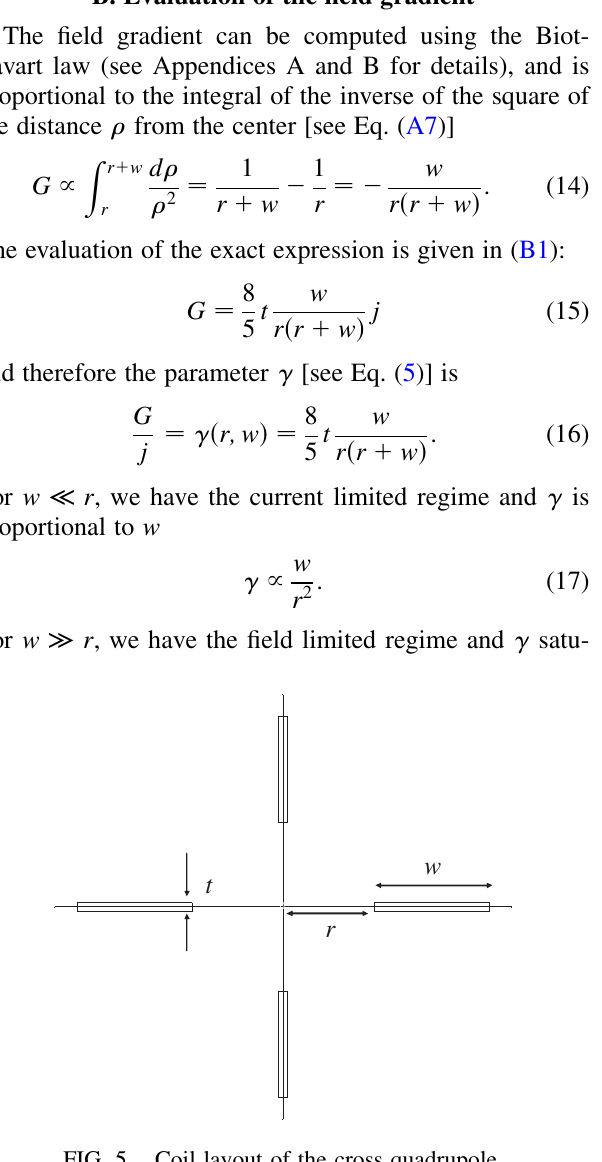
FIG. 5. Coil layout of the cross